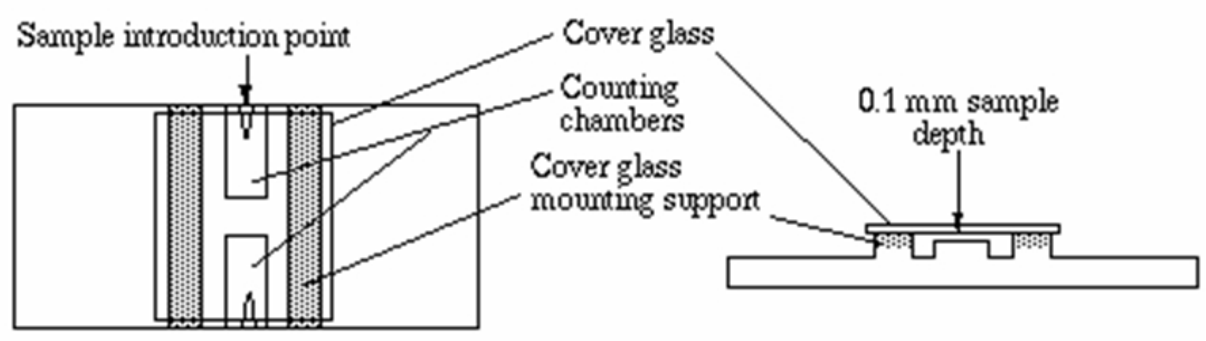
Fig. 1. Sample introduction in